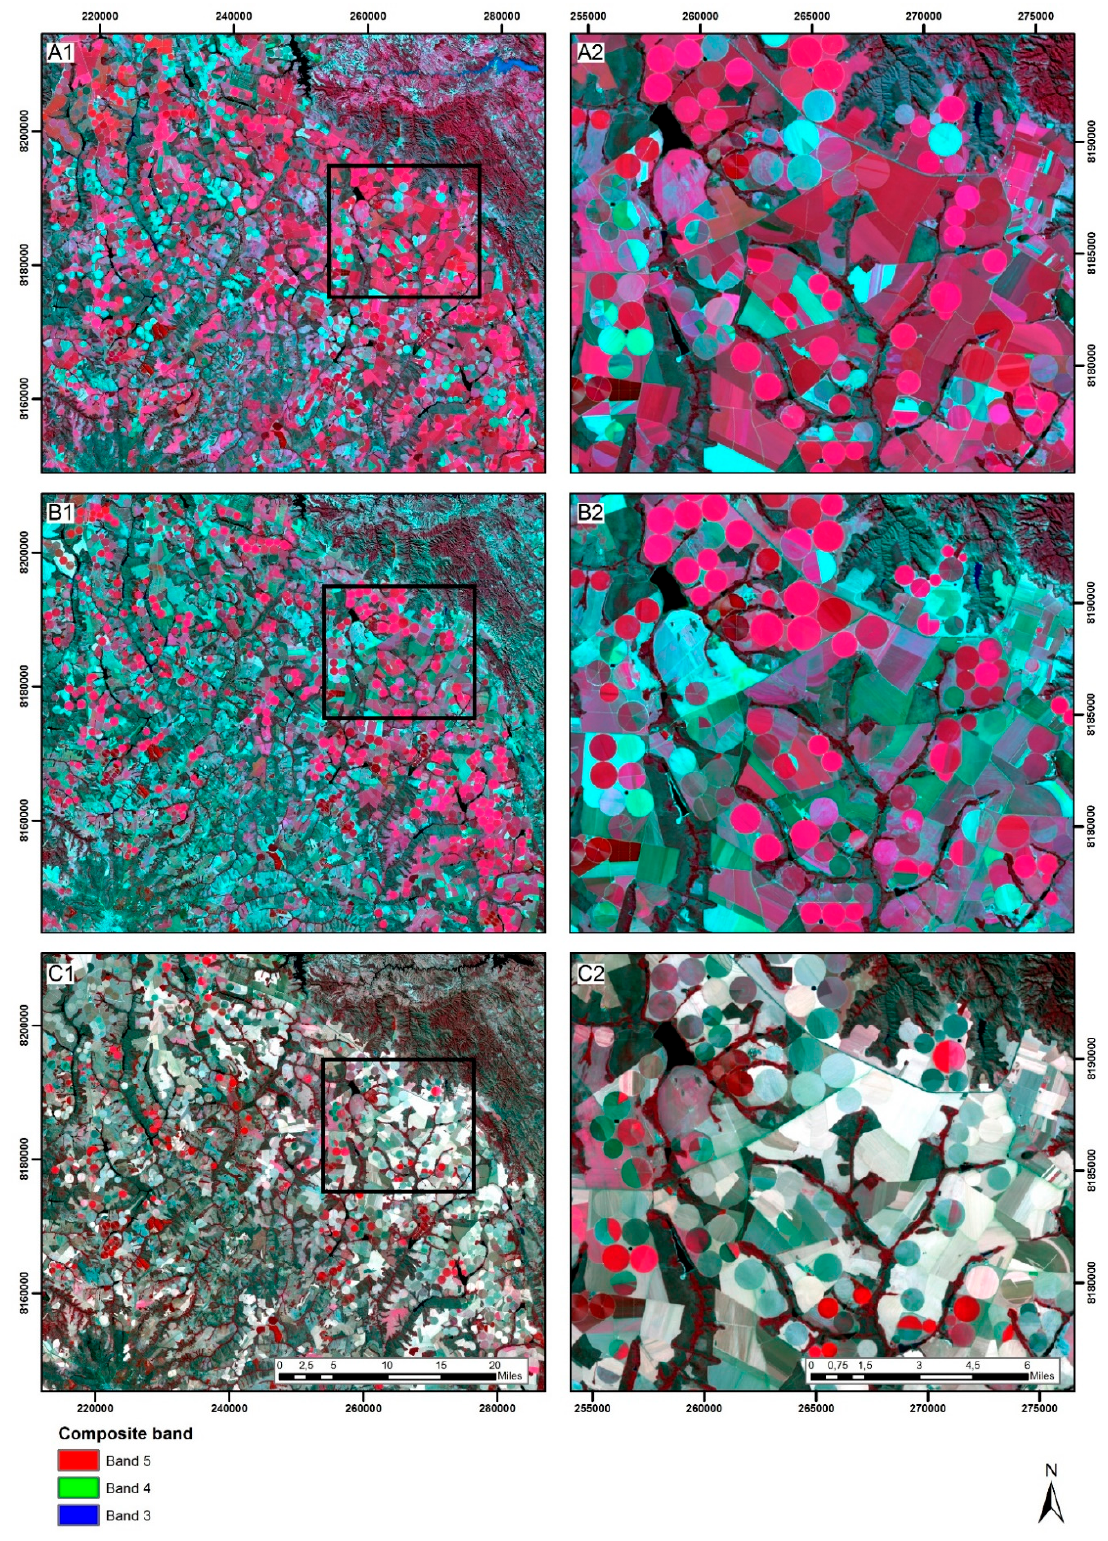
Figure 6. Landsat images from the three different periods with different percentages of photosynthetic vegetation: ( A1 ) rainy period (May 2019), ( A2 ) zoomed image from the rainy period ( B1 ) beginning of the dry period (June 2018), ( B2 ) zoomed image from the beginning of the dry period ( C1 ) critical dry season (August 2019), and ( C2 ) zoomed image from the critical dry season. With the following composition, the red areas represent the photosynthetically active regions.